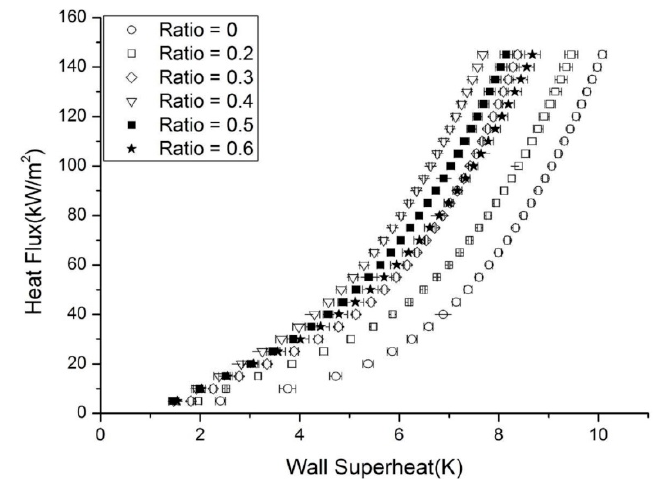
Figure 8. The effect of the pattern size on the pool boiling curves of the various tested surfaces.